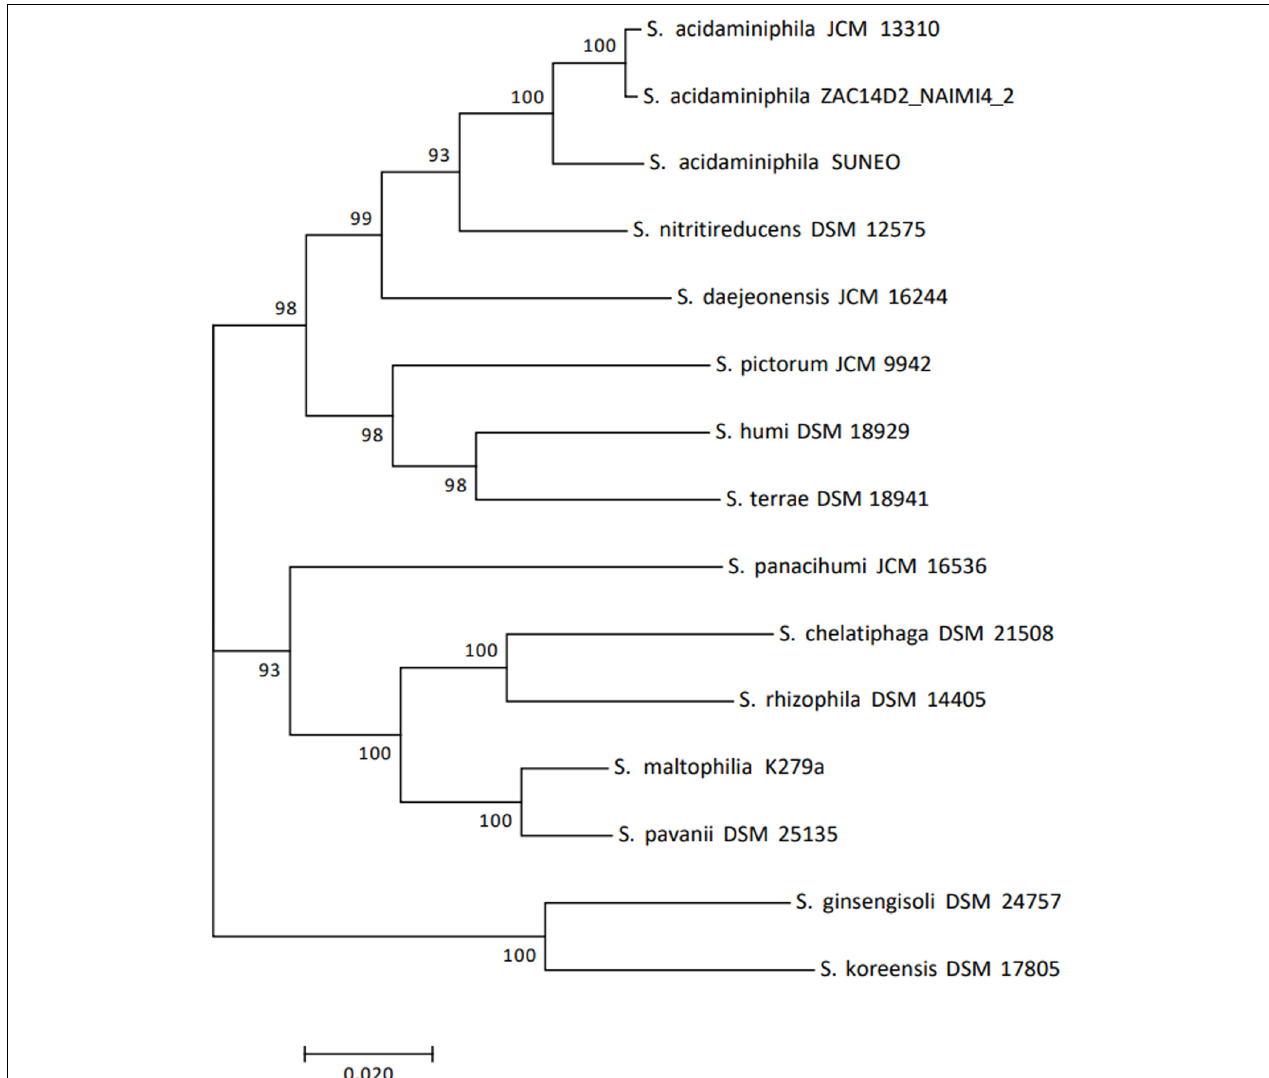
FIGURE 4 | Phylogenetic tree of S. acidaminiphila SUNEO and related type strains of Stenotrophomonas species based on the phylogenetic analysis of seven housekeeping genes (16S rRNA, atpD , guaA , mutM , nuoD , ppsA , and recA